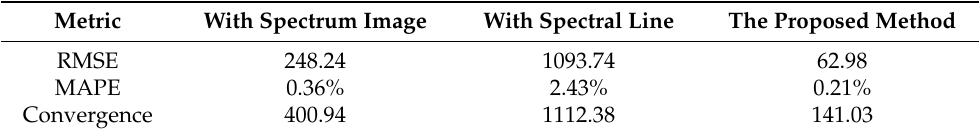
Table 1. Metrics comparison of different prediction